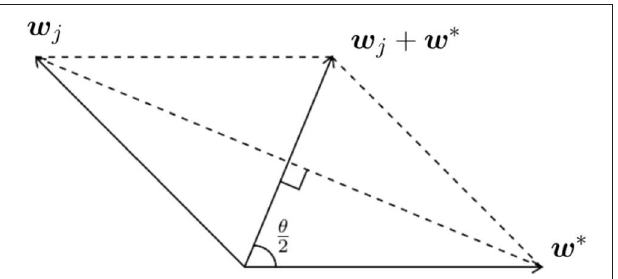
FIGURE 2 | Geometry of w t and w ∗ when